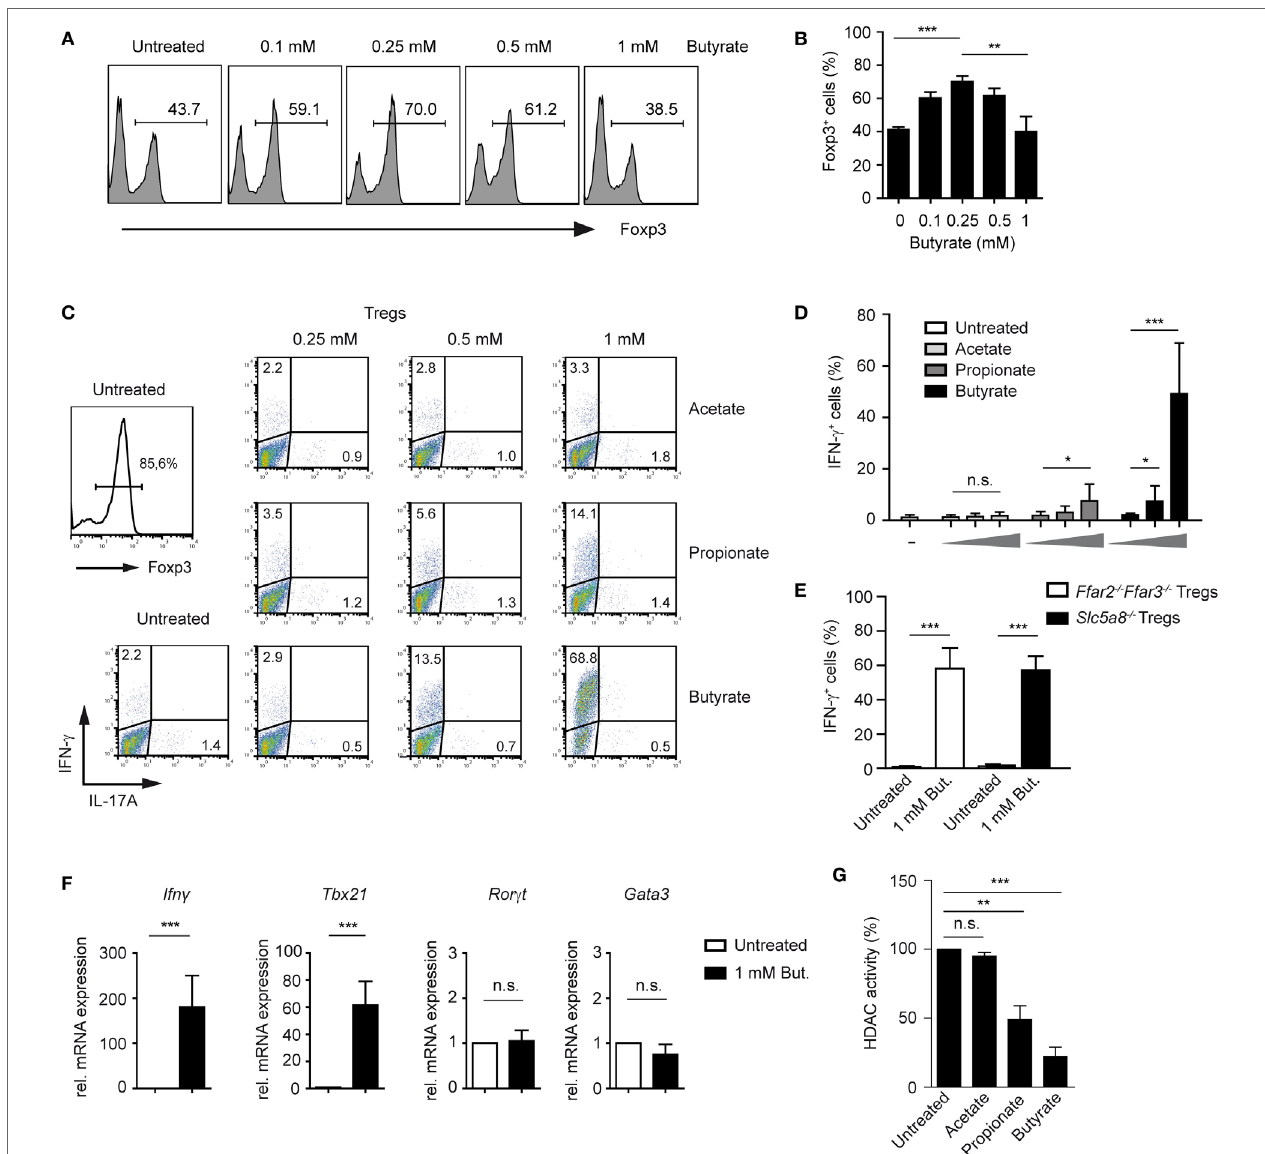
FigUre 2 | Butyrate induces the expression of IFN- γ and T-bet during the differentiation of regulatory T cells (Tregs). (a,B) The impact of increasing butyrate concentration on the Foxp3 expression was analyzed in T cells cultured under Treg-inducing conditions (1 ng/ml TGF- β 1 and 100 U/ml rhIL-2) on day 6 of cell culture. The bars (B) represent mean ± SEM of three independent experiments; ** P = 0.001–0.01, *** P < 0.001. (c,D) CD4 + T cells were differentiated into Tregs under optimal Treg-inducing conditions with 2 ng/ml TGF- β 1 and 100 U/ml rhIL-2 in the presence of increasing concentrations of acetate, propionate, or butyrate. At day 6 of the cell culture, cells were restimulated for 4 h with PMA/ionomycin in the presence of Brefeldin A, stained for IFN- γ and IL-17A, and analyzed by flow cytometry. Bars (D) represent the mean ± SEM of IFN- γ + cells. Two independent experiments were performed. * P = 0.01–0.05, *** P < 0.001, n.s., not significant. (e) CD4 + T cells isolated from LNs and spleens of Ffar2 − / − Ffar3 − / − and Slc5a8 − / − mice were cultured under optimal Treg conditions for 6 days. The frequency of IFN- γ + cells in the absence or presence of 1 mM sodium butyrate is shown. *** P < 0.001. (F) CD4 + T cells purified from WT mice were cultured under optimal Treg conditions for 3 days with or without 1 mM butyrate. The expression of Ifn γ , Tbx21 , Ror γ t , and Gata3 was analyzed by qRT-PCR. Data are the mean ± SEM of two independent experiments. *** P < 0.001, n.s., not significant. (g) CD4 + T cells were differentiated under optimal Treg conditions for 3 days and subsequently histone deacetylase (HDAC) inhibition assay in the presence of acetate, propionate, or butyrate was performed. Bars represent the mean ± SEM; ** P = 0.001–0.01, *** P < 0.001, n.s., not